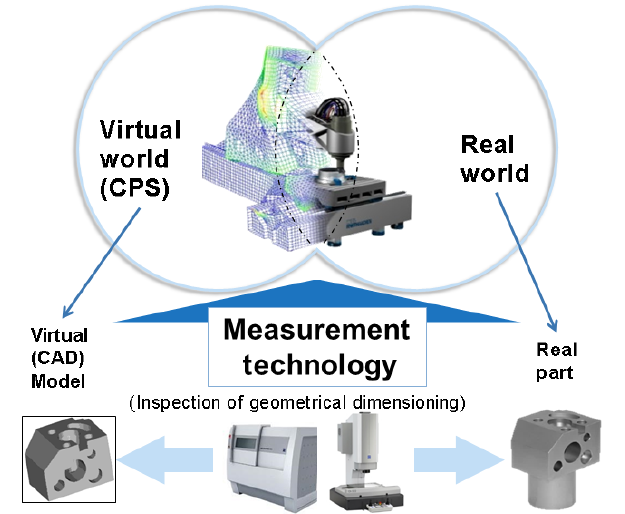
Figure 11. Measurement technology for linking the virtual and real worlds, with an example from coordinate metrology for comparing the nominal (CAD model) and actual product